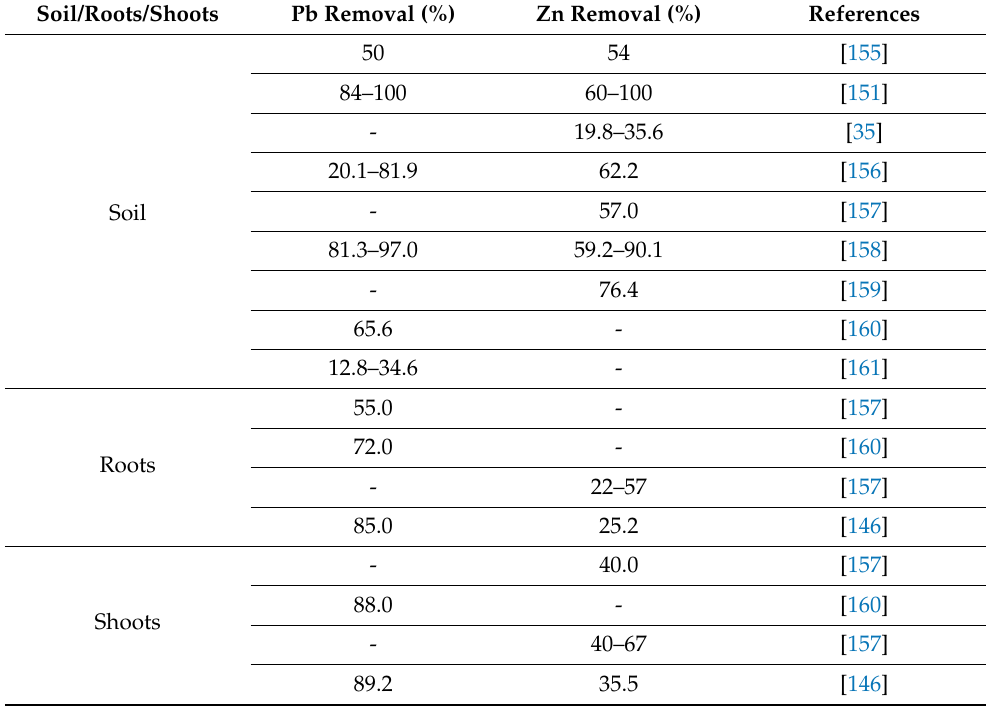
Table 4. Decreased availability of Zn and Pb in soil and maize due to amendment with